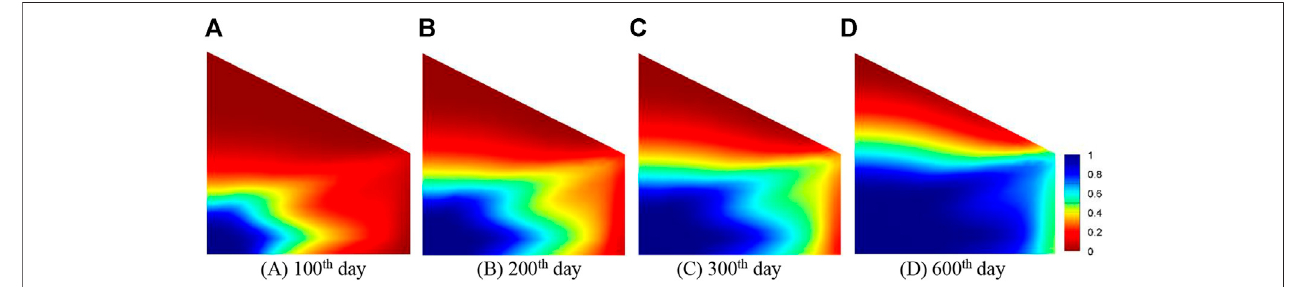
FIGURE 14 | The water saturation and magnetic anomaly distribution at different time. (A – D) respectively show the water saturation at 100th, 200th, 300th, 600th day.